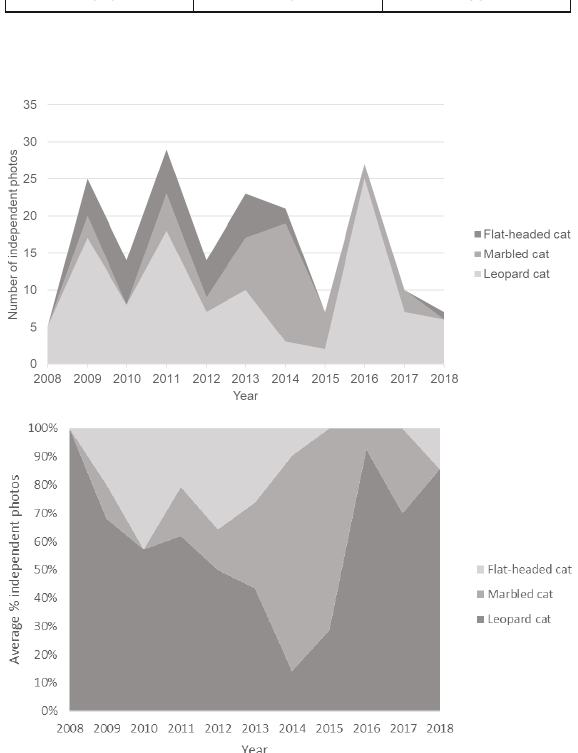
Figure 2. Mean detection of small wild cat species from the inception of the camera trap surveys in Sebangau since 2008.